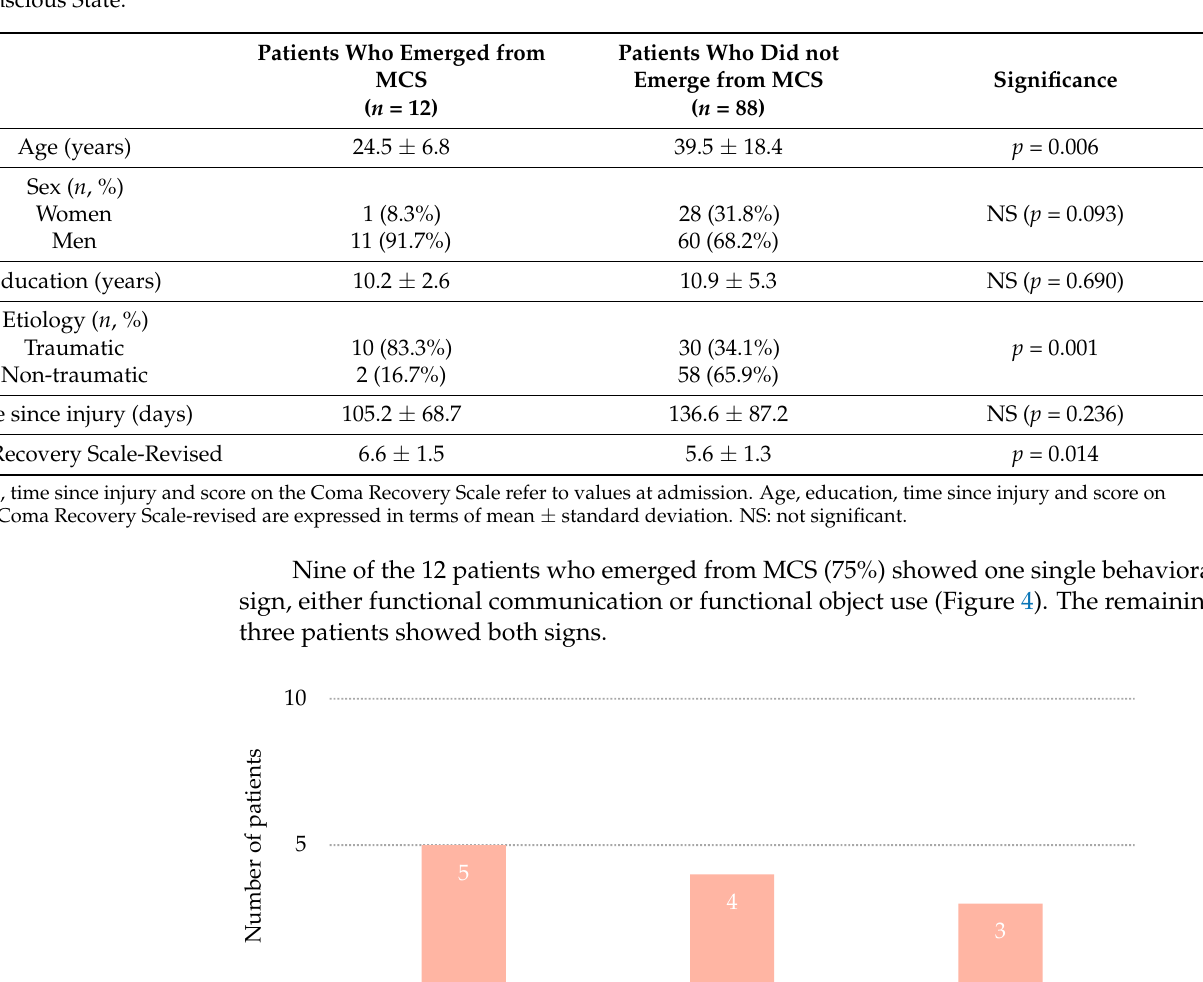
Table 4. Baseline demographic and clinical characteristics of the patients who did and did not emerge from Minimally Conscious State.